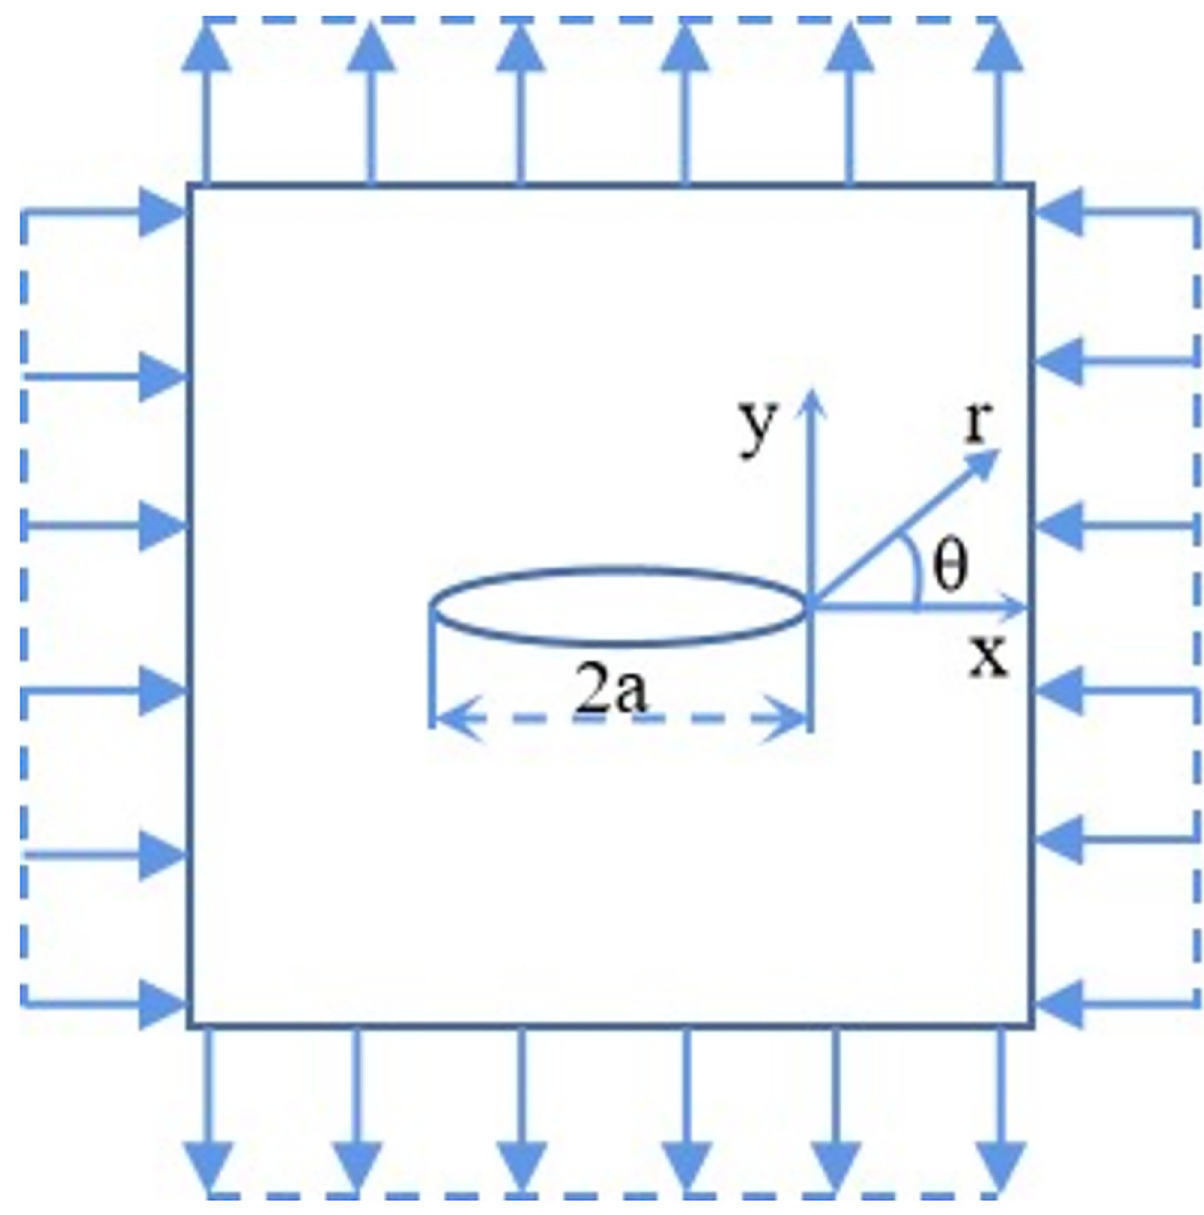
Fig 8. The fracture characteristics of rock